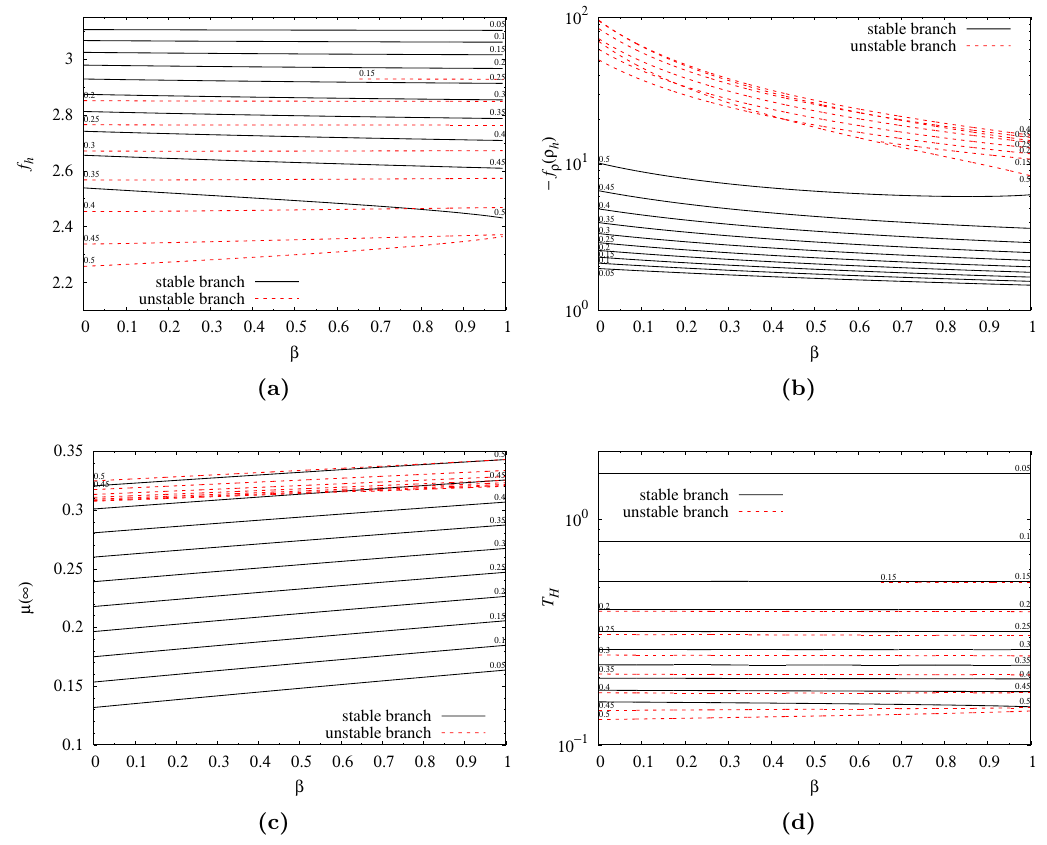
Figure 6 . Stable (black solid lines) and unstable (red dashed lines) branches of solutions in the 2 + 4 + 8 model with (cid:13) = 1: (a) the value of the pro(cid:12)le function at the horizon, f h ; (b) the derivative of the pro(cid:12)le function at the horizon, f (cid:26) ( (cid:26) h ); (c) the ADM mass, (cid:22) ( 1 ); (d) the Hawking temperature T H , all as functions of the Skyrme-term coe(cid:14)cient, (cid:12) . The numbers on the (cid:12)gures indicate the di(cid:11)erent values of (cid:26) h = 0 : 05 ; 0 : 1 ; : : : ; 0 :